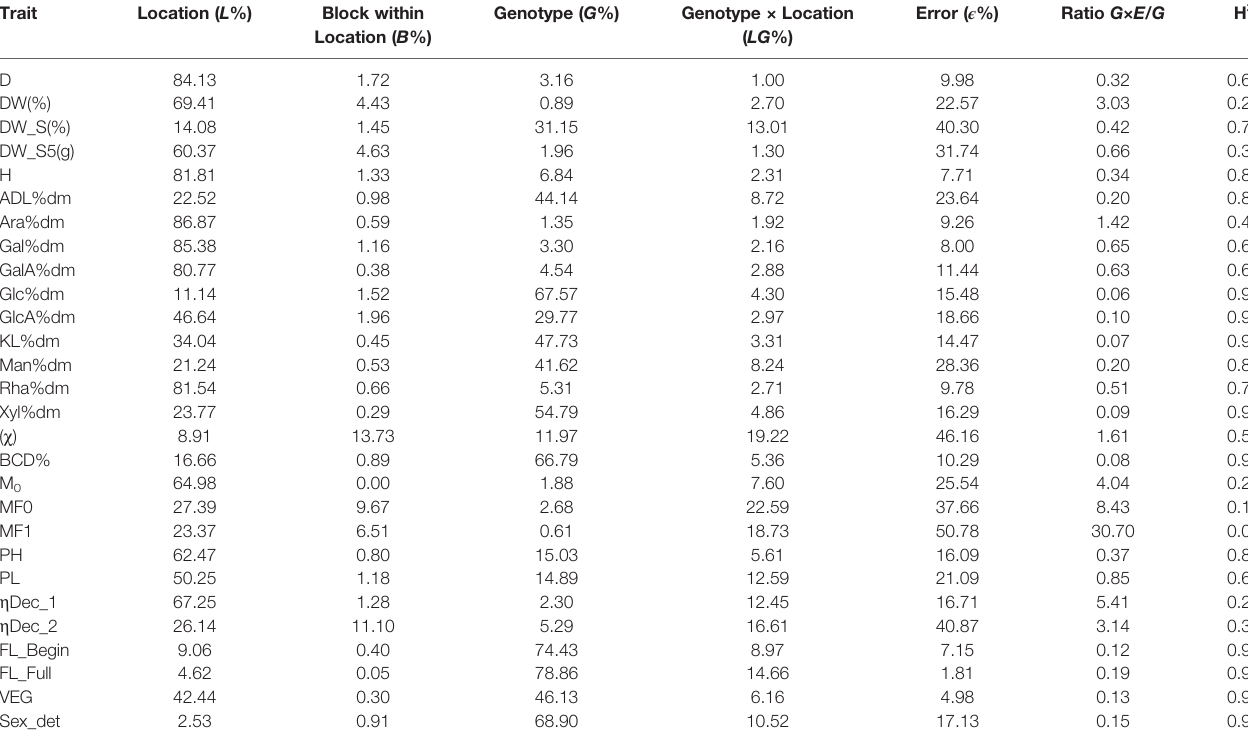
TABLE 7 | Variance components and broad-sense heritability (H 2 ) of 28 traits calculated with a random effects model. Trait Location ( L %) Block within Genotype ( G Location ( B %)